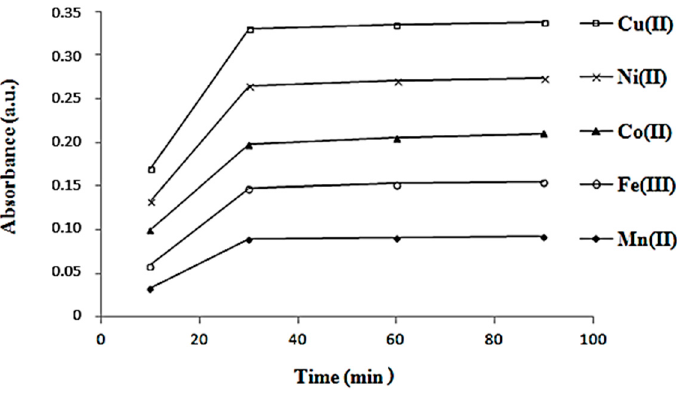
Figure 4. Determination of the optimal reaction time for the synthesis of complexes between ligand L and metal cation M (Mn 2+ , Fe 3+ , Co 2+ , Ni 2+ , and Cu 2+ ) using a spectrophotometric method.